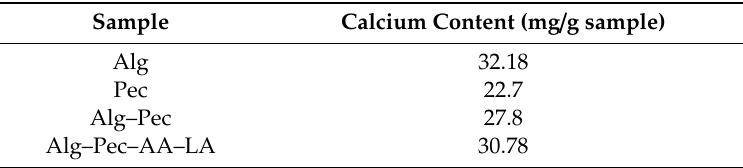
Table 7. Calcium content of pectin, alginate, and their biocomposite